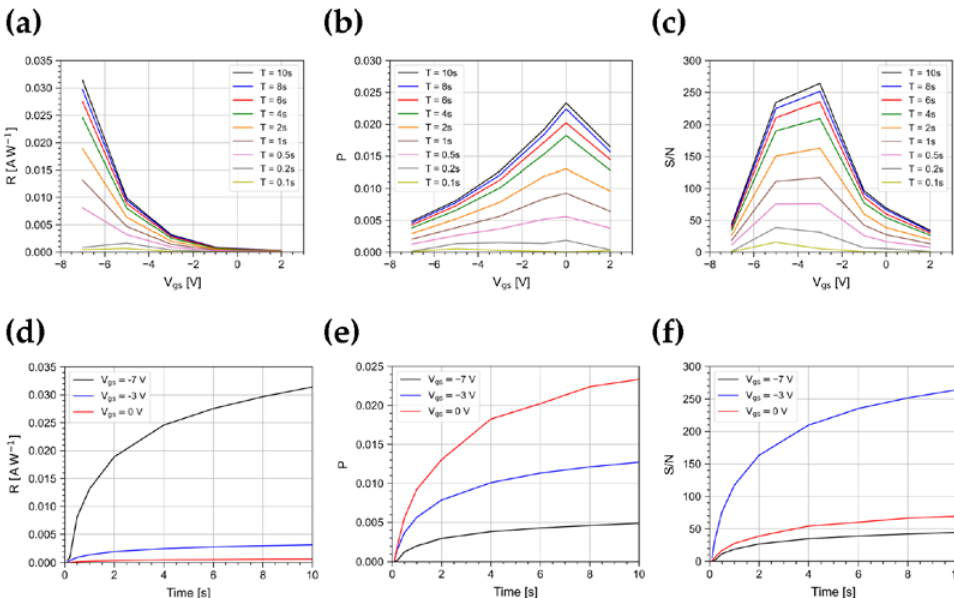
Figure 4. ( a ) Responsivity, ( b ) photosensitivity, and ( c ) signal-to-noise ratio as a function of V gs for V ds = −1 V for light pulse widths from 0.1 s to 10 s. ( d ) Responsivity, ( e ) photosensitivity, and ( f ) signal-to-noise ratio as a function of the light pulse width at V gs = −7, −3, 0 V and V ds = −1 V. All these FoMs are shown at an irradiance of 500 nW/cm 2 .